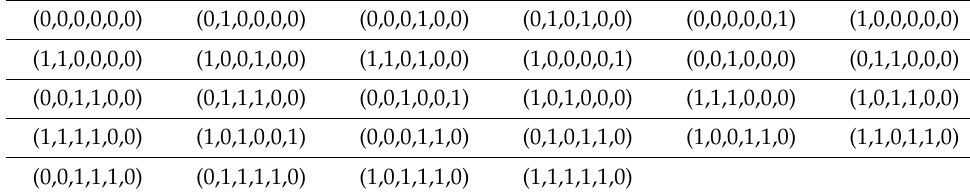
Table 2. Possible feasible game